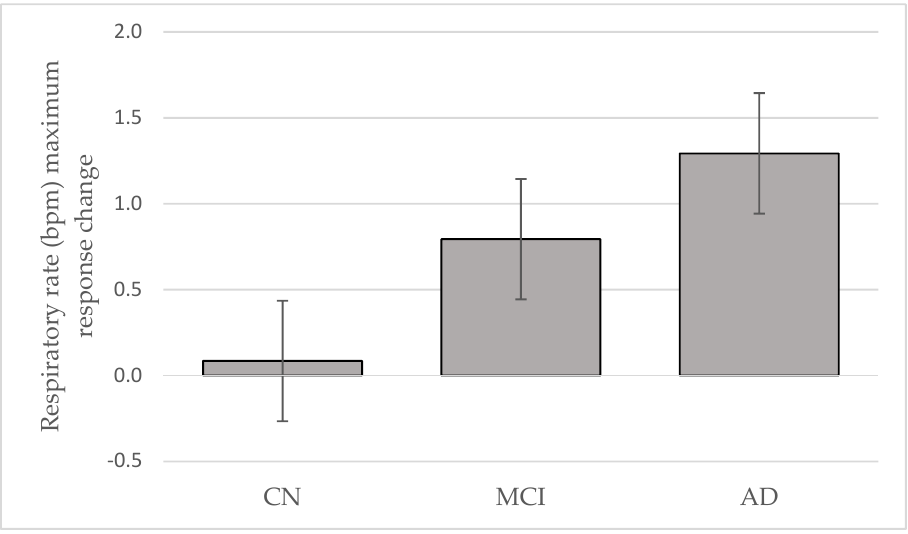
Figure 2. Respiratory rate maximum response change to oral appliance therapy after 4 weeks in cognitively normal (CN), mild cognitive impairment (MCI) and Alzheimer’s disease (AD) (Mean ± SE). RRmax ( ∆ mean) with Tx was smallest in the CN group suggesting that homeostatic regulation of cardio-respiration dynamic equilibrium during sleep was conserved. The mean RR max ( ∆ mean) was almost two times greater in AD, compared with MCI. We spec- ulate that this shift might represent some plasticity remaining within the neuronal